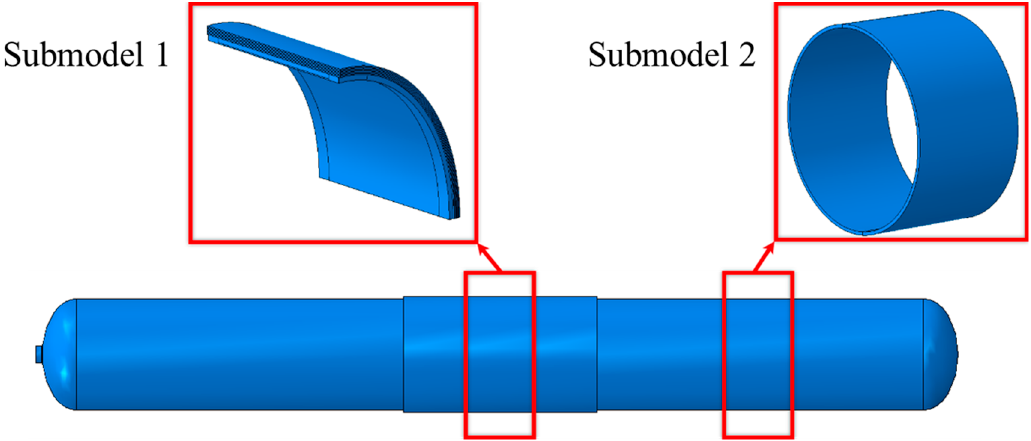
Figure 6. Submodelled positions of the global CAD model.